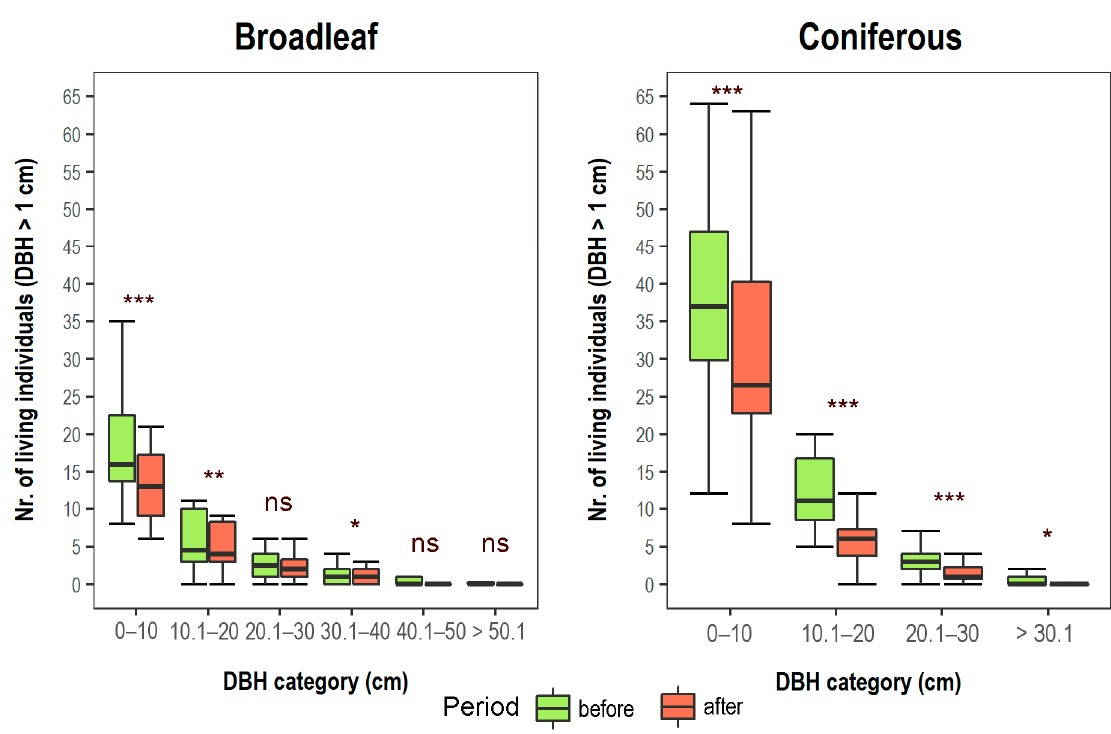
Figure 4. Differences in DBH distribution of living trees, shrubs, and saplings (DBH ≥ 1 cm) between pre-disturbance (before typhoon) and post-disturbance (after typhoon) broadleaf ( left panel ) and coniferous ( right panel ) forests (40 permanent plots). The level of significance is indicated above the boxes: ns: non-significant; * p < 0.05; ** p < 0.01; *** p < 0.001.